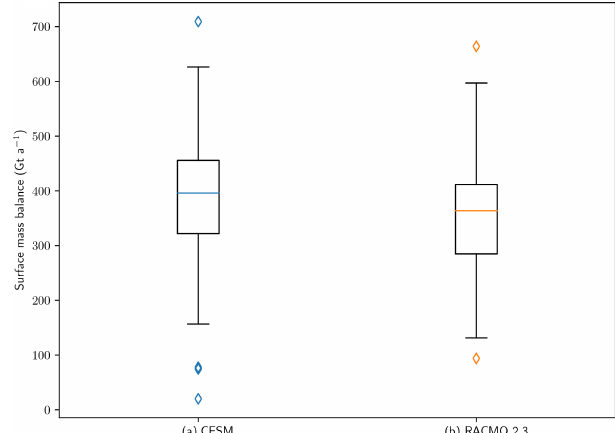
Figure 10. Box plot of (a) CESM annual surface mass balance for the entire simulation, 1851–2006, compared to the (b) RACMO 2.3 annual surface mass balance for 1961–2013. The diamonds repre- sent extreme values within the series as explained in the